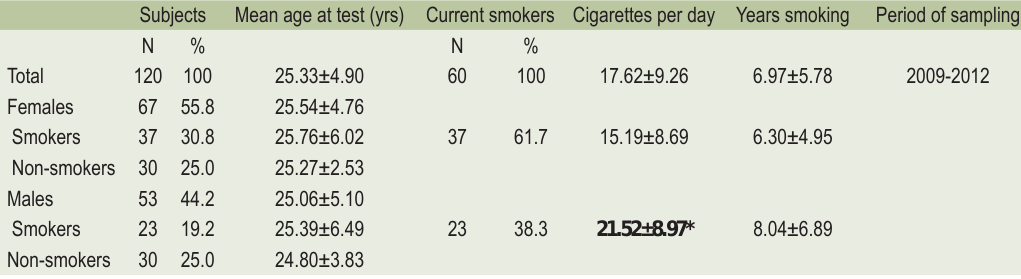
SD, standard deviation. Signi fi cance was accepted at P < 0.05. Signi fi cant results in bold. Sex: *P <